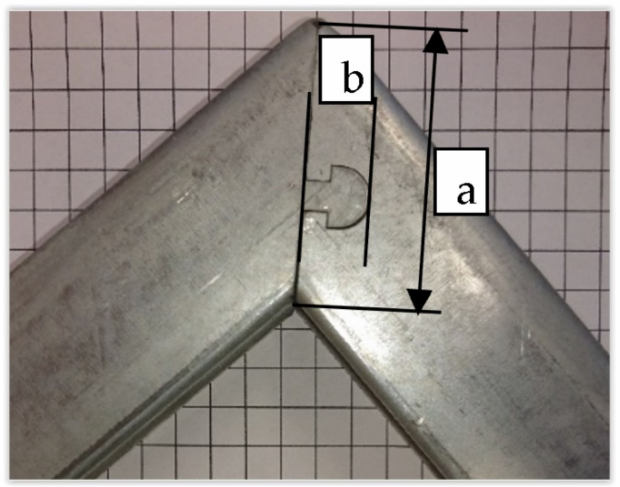
Figure 6. Limitations of the positioning of the lock: ( a ) chord, ( b ) lock